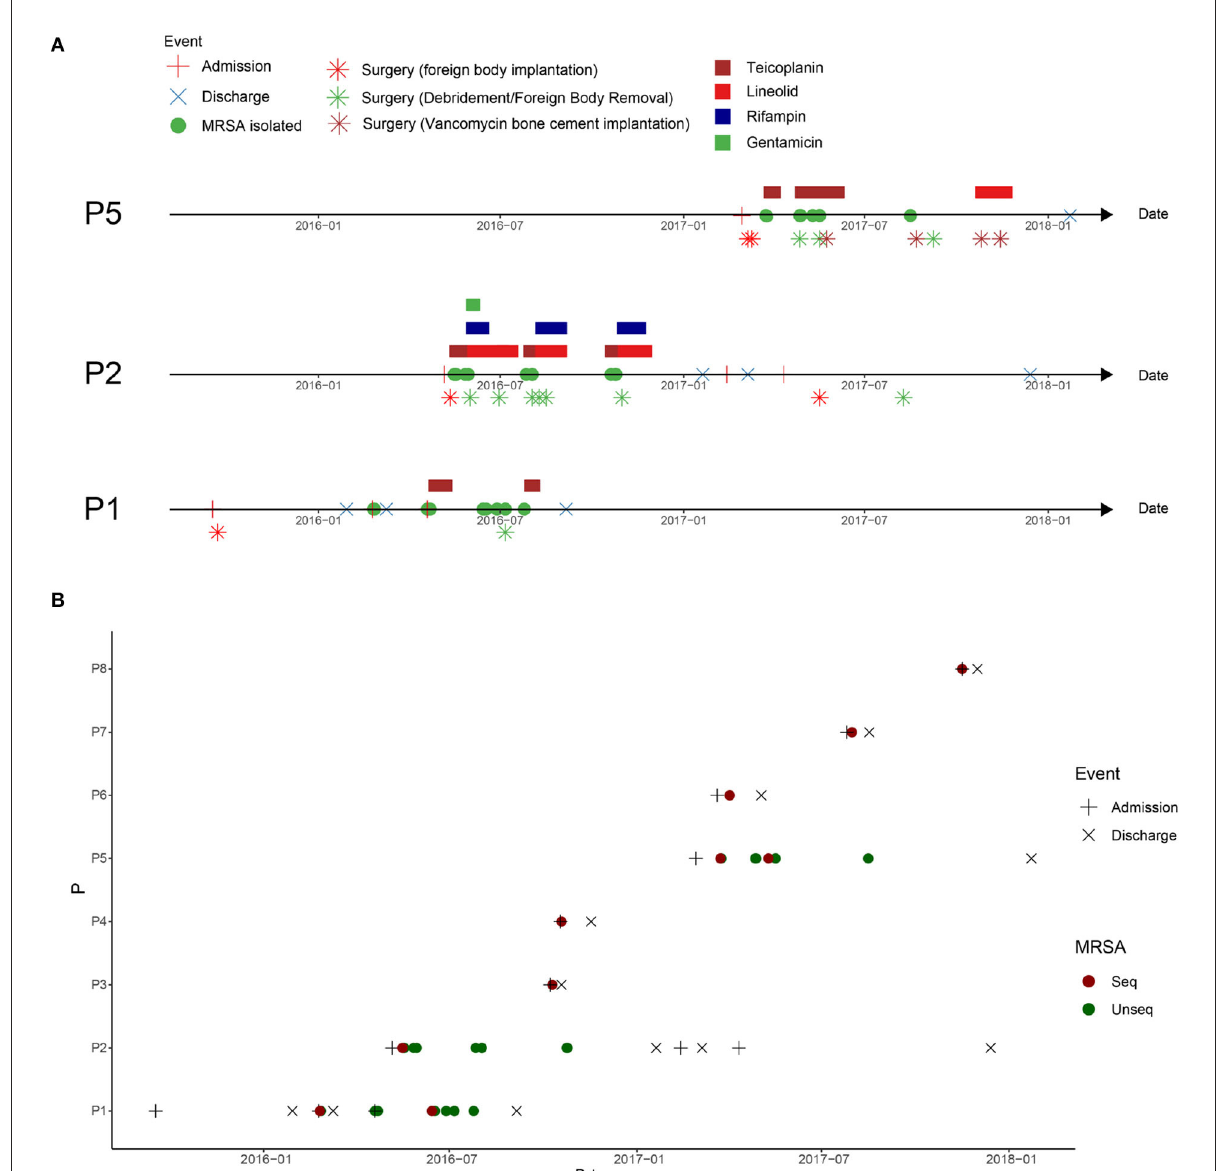
FIGURE1 Clinical events in patients with methicillin-resistant Staphylococcus aureus (MRSA) infection in the orthopedic surgery ward. (A) Clinical events in patients with MRSA infection at the surgical site after osteoarthritis surgery. P1: patient 1, P2: patient 2, and P5: patient 5. (B) Timeline of MRSA isolation from MRSA-infected patients in this ward between admission of P1 and discharge of P5. The dotted line represents the screening time of the medical staff in the ward.